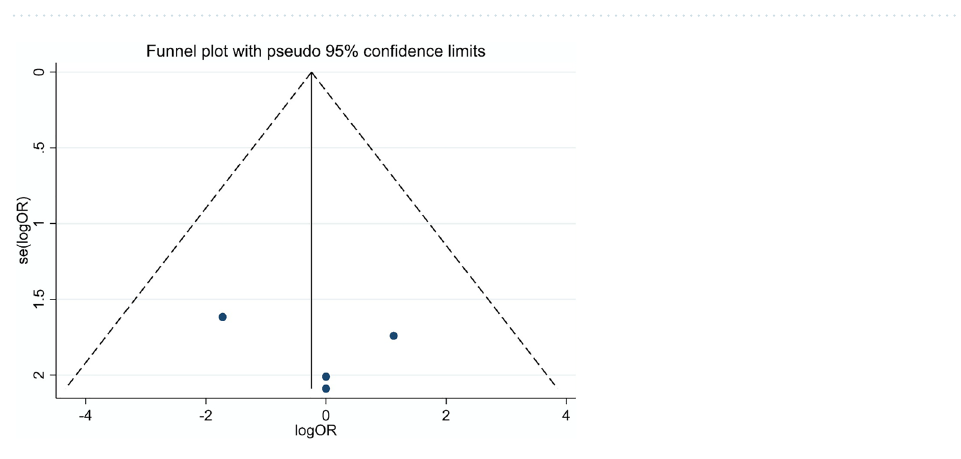
Figure 3. Funnel plot of studies assessing clinical success of different treatment modalities of